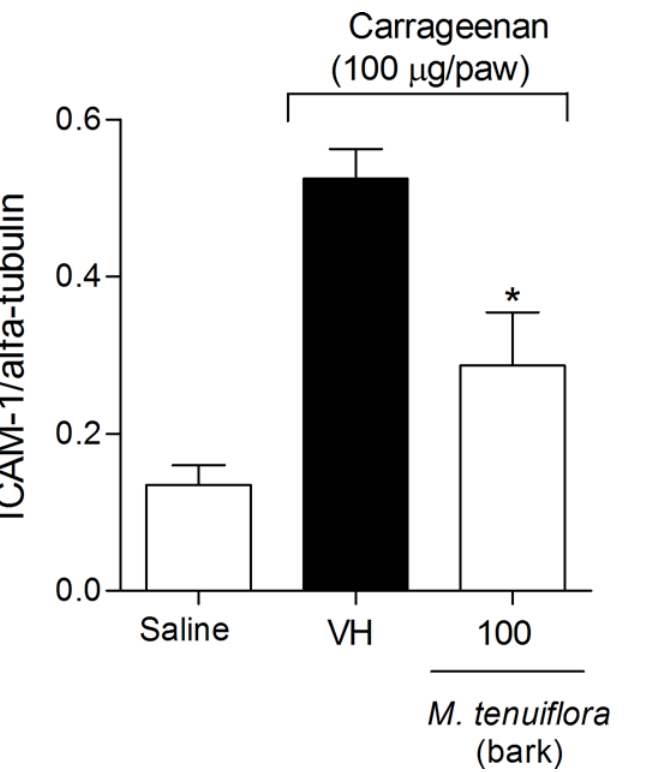
Fig 10. Effect of the ethanolic extract of M . tenuiflora bark on ICAM-1 expression in the mesentery of mice. VH is the vehicle group (negative control). The ethanolic extract of M . tenuiflora bark was tested at the dose of 100 mg/kg (s.c.). The results are presented as the mean ± S.D. (n = 8). The optical density of the bands for ICAM-1 was normalized to α -tubulin expression. Statistical significance was calculated by ANOVA followed by Bonferroni's test. * P < 0.05 compared to the vehicle-negative control treated